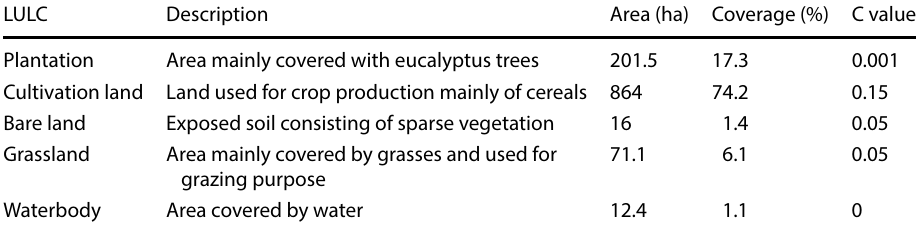
Table 5 LULC and C-factor value of the